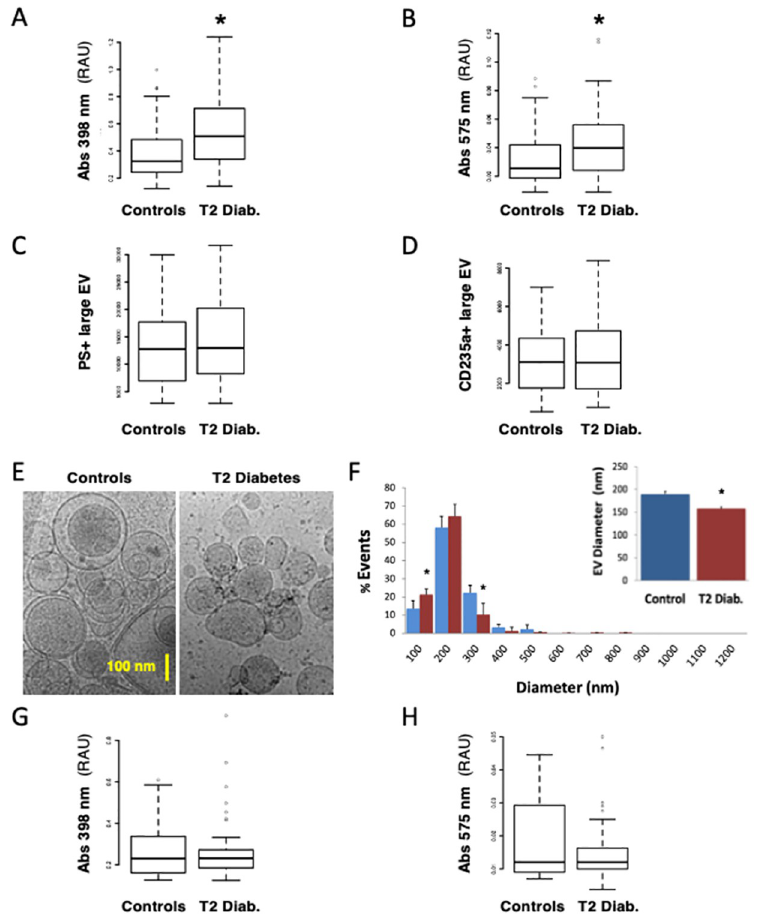
Fig 1. Intravascular hemolysis in patients with type 2 diabetes vs. control subjects. We quantified direct biomarkers of intravascular hemolysis (IVH) in 109 patients with type 2 diabetes (T2D) vs. 65 non-T2D control subjects, focusing on RBC contents and extracellular vesicles (EV). RBC contents and RBC membrane EV were quantified in platelet-free plasma of control (Blue) vs. T2D patients (Red). Heme-related absorbance was measured at Soret band peaks at 398 nm (A) and 575 nm (B) . Circulating large EV were measured by flow-assisted cell sorting after labeling of surface PS with fluorescent annexin-A5 (C) or a RBC-specific anti-CD235a (glycophorin-A) antibody (D) . EV from platelet-free plasma were analyzed by cryogenic, transmission electron microscopy (E) . EV were identified as objects between 40 and 1200 nm in diameter, with electron-dense membranes and circularity. EV diameters were extracted and presented as size-distribution by 100 nm increments, or as average size (F) . Absorbance associated to EV was deduced from signals remaining after depleting EV by ultracentrifugation (25000 g, 4 h) (G-H) . ( � ) p < 0.05 vs.